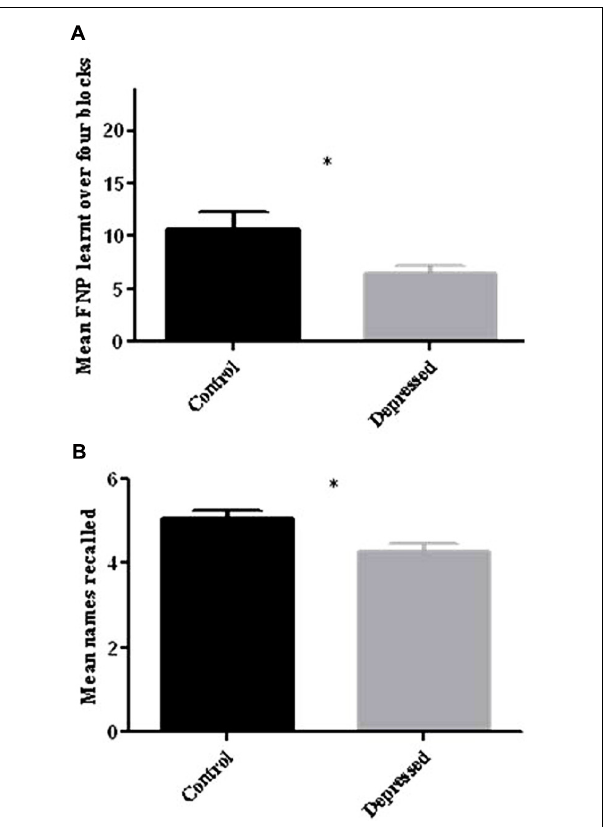
FIGURE 2 | (A) Recall between-groups.When compared to controls patients with depression showed impaired learning for the six FNP at learning blocks 1 and 4, as well as showing an impairment at the delayed cued-recall of FNP (* p < 0.05). (B) Learning within-groups.When assessed for learning with-groups the control group performed significantly better in the last two blocks relative to the first two blocks (*1 relative to block 1; *2 relative to block 2), and the depressed group performed significantly better in blocks 2–4 relative to the first block (* p < 0.05, ** p < 0.01). Error bars represent SEM.